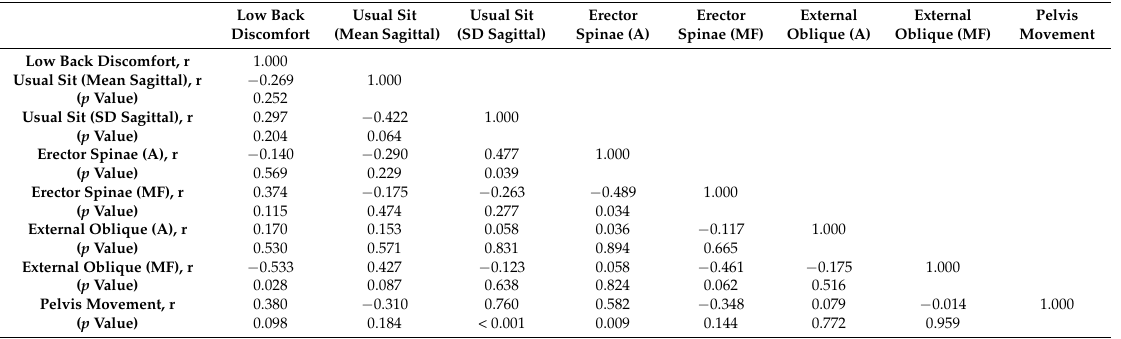
Table 4. Change score correlations (r) for low back discomfort and low back angle, pelvis movement and muscle fatigue amplitude (A) and median frequency (MF) measures over 2 h prolonged sitting.